Question: Briefly state, in one sentence, what is plotted here.
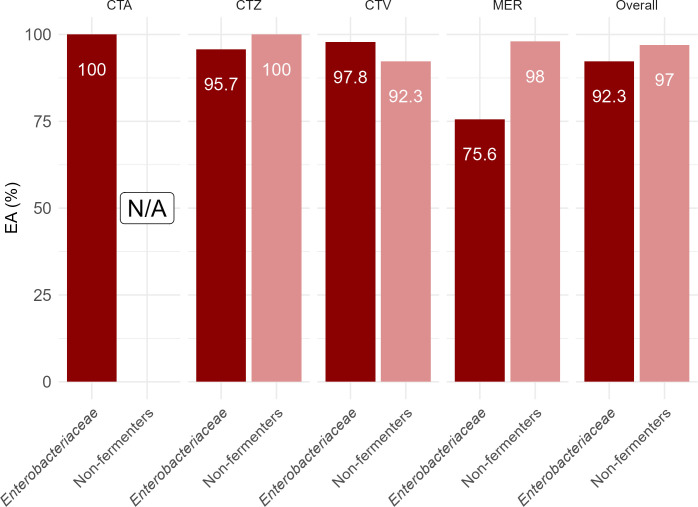
Answer: Overview of essential agreement for QuickMIC vs BMD: EA rates for the four antibiotics investigated, split up for Enterobacteriaceae and non-fermenters in different shades of red for QuickMIC compared to BMD. CTA, cefotaxime; CTV, ceftazidime/avibactam; CTZ, ceftazidime; MER, meropenem; N/A, not applicable.